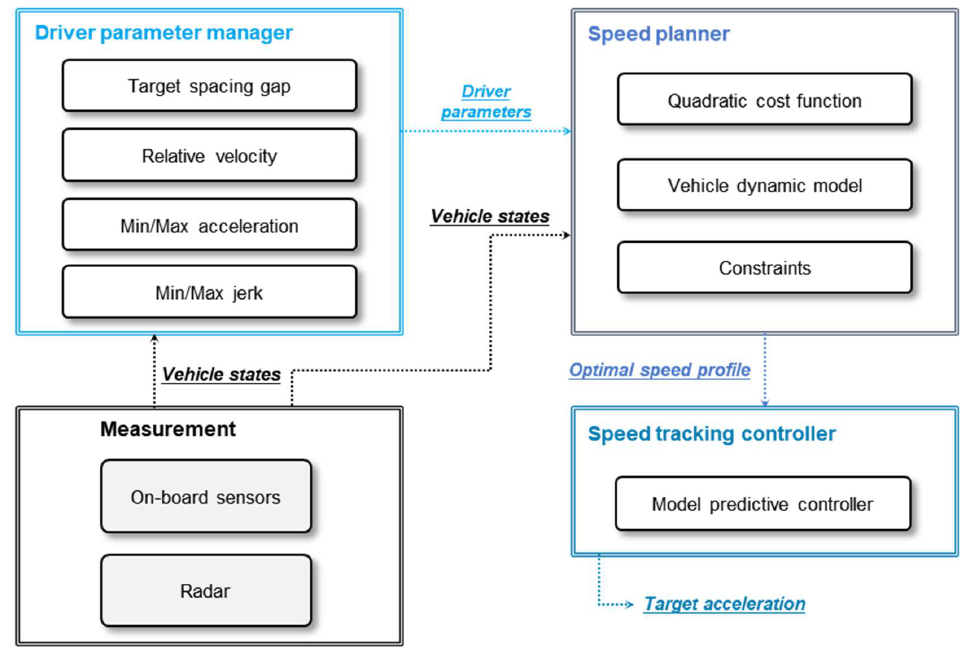
Figure 5. The overall framework of driver characteristics oriented adaptive cruise control (DCO-ACC).